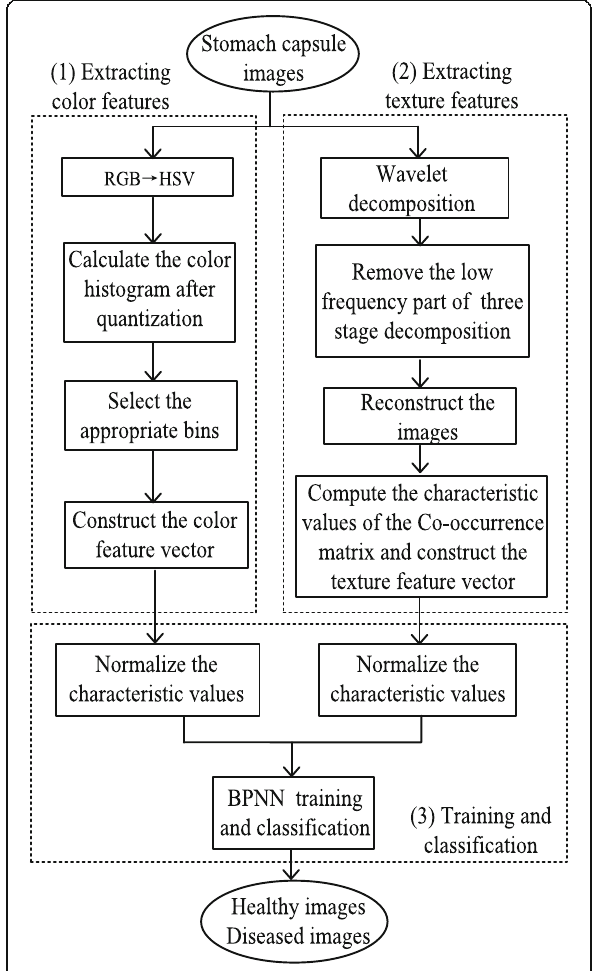
Fig. 1 Flow chart of the proposed